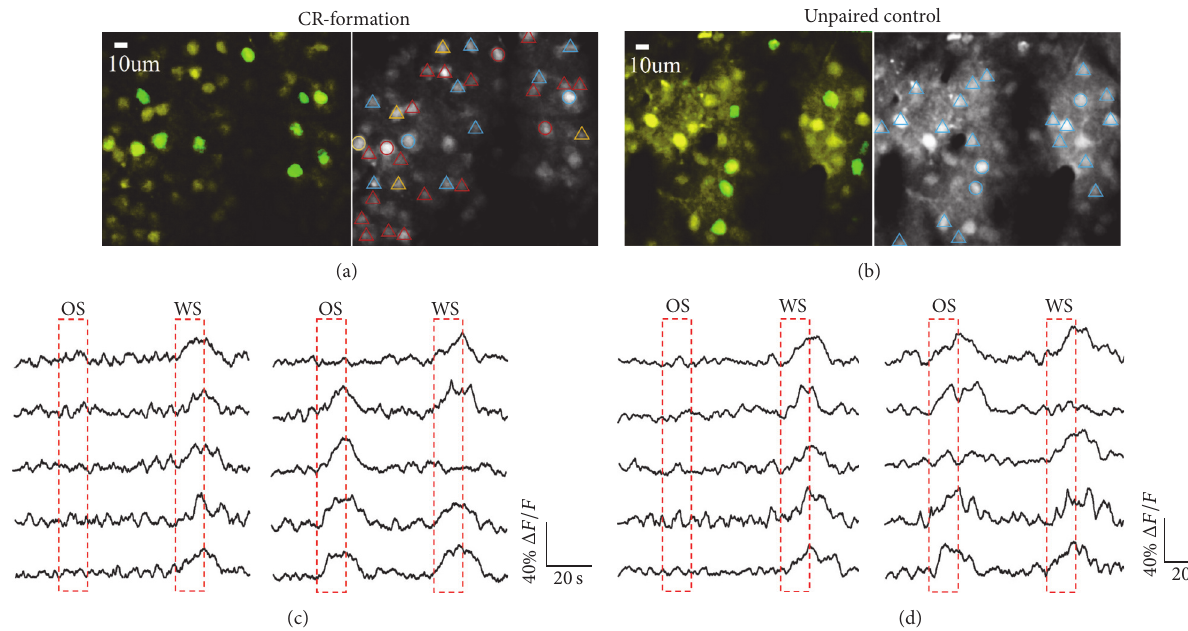
Figure 1: Glutamatergic and GABAergic neurons in the barrel cortex respond to the odor signal (OS) and whisker signal (WS) after their pairing. Cellular activities were detected by imaging Ca 2+ signals under a two-photon microscope in control ( 𝑛 = 7 ) and CR-formation mice ( 𝑛 = 7 ), in which glutamatergic neurons were genetically labeled by YFP and GABAergic neurons were labeled by GFP. (a) Left panel shows the images of the glutamatergic neurons (yellow) and GABAergic neurons (green) in the barrel cortex from a CR-formation mouse. Right panel shows the neurons in response to WS and/or OS, which are defined as Δ𝐹 larger than 2.5-fold of standard deviation of baseline values. The neurons labeled by red are WS/OS-responsive cells. The neurons labeled by blue respond to WS. The neurons labeled by yellow respond to OS. (b) Left panel shows the images of glutamatergic neurons (yellow) and GABAergic neurons (green) in the barrel cortex from an unpaired control mouse. Right panel illustrates the neurons labeled by blue in response to WS. In (a) ∼ (b), the glutamatergic neurons are marked as triangles and GABAergic neurons are marked as circles. (c) shows the digitized Ca 2+ signals recorded from glutamatergic neurons in response to WS versus OS from unpaired control mouse (left panel) and CR-formation mouse (right). (d) shows the digitized Ca 2+ signals recorded from GABAergic neurons in response to WS versus OS from an unpaired control mouse (left panel) and CR-formation mouse (right). The calibration bars are 40% Δ𝐹/𝐹 and 20